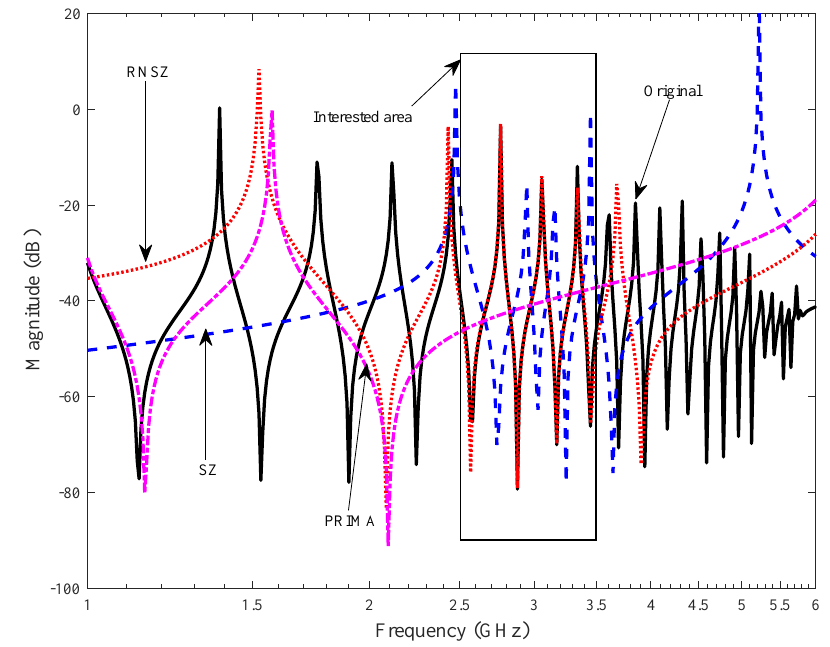
Figure 3. Frequency response of a on-chip RLC network with original system order of n = 79. The reduce models of using reduce norm spectral zero (RNSZ), PRIMA and spectral zeros (SZ) methods are of order N = 10. The reduce model generated by RNSZ closely matches the fine details of the original system compared to other techniques.